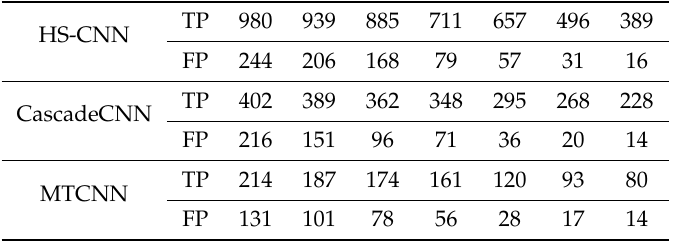
Table 1. The pair of true positive and false positive predictions over different thresholds. HS, head-shoulder.